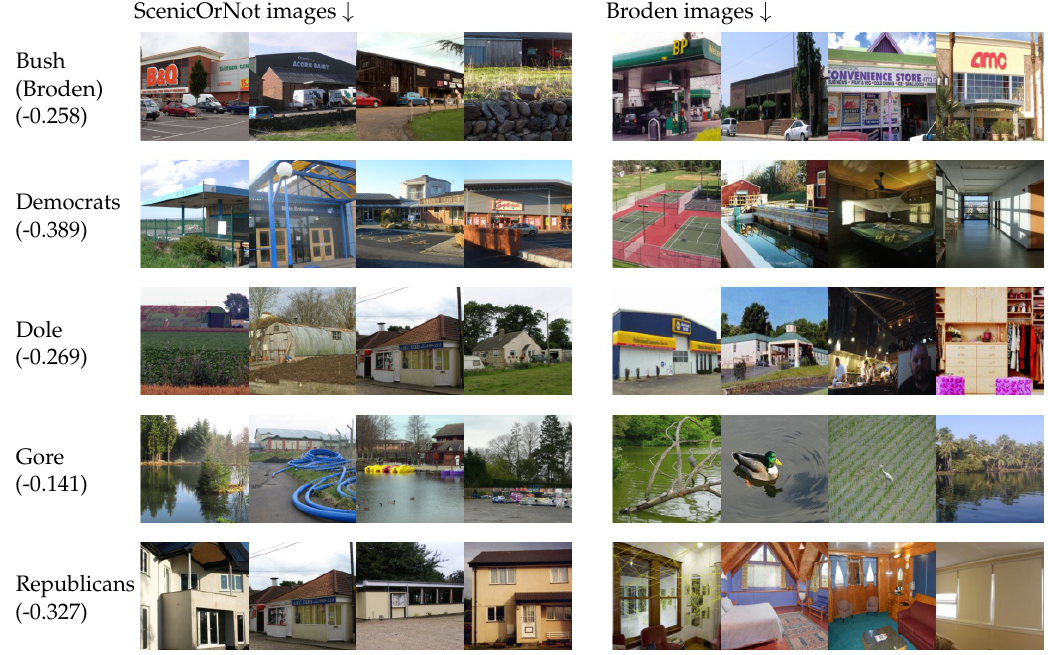
Figure 15. Closest images for bush, a concept that has been trained with visual examples from Broden (top row) and its corresponding neighboring concepts from GloVe. Each concept shows its correlation with scenicness in the latent